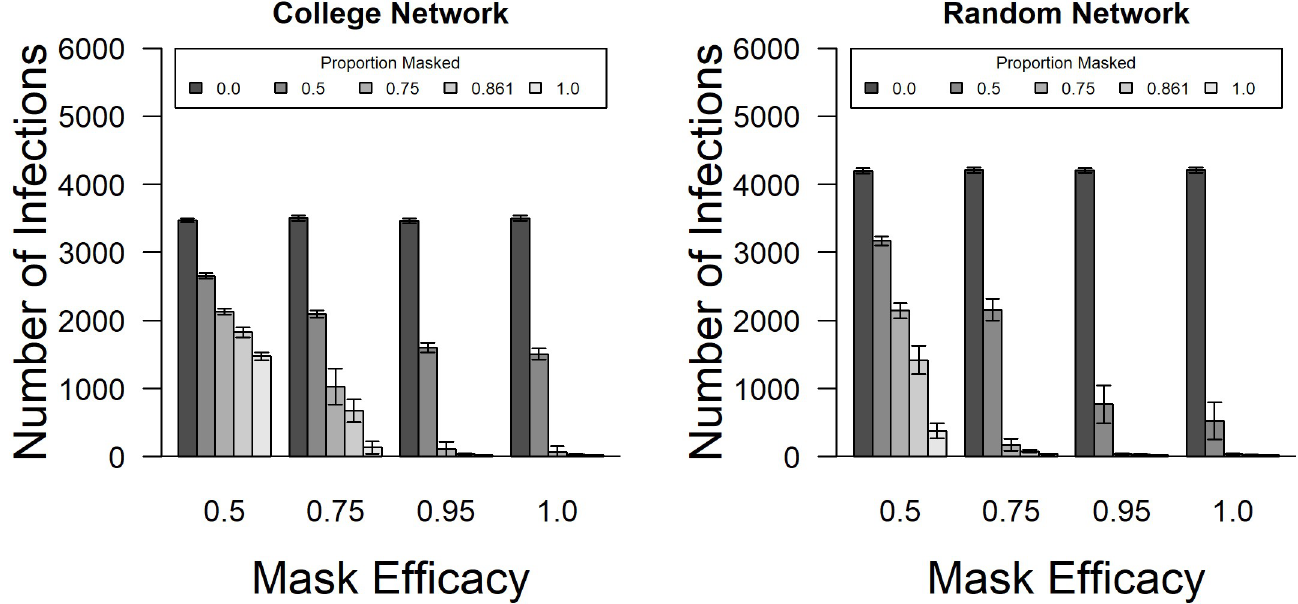
Fig 10. Comparison of the number of infected individuals in response to masking levels and efficacies between networks. The number of individuals that became infected under different levels of masking and mask efficacy for both the college and random networks. This three-way interaction was statistically significant (F = 74.14; df = 12, 5760; p < 0.001) along with the two-way interactions within network types. Without masking more students contracted the disease on the random networks but masking proved less effective, comparatively, on the college network due to the high clustering of students. Error bars are ± 95% confidence